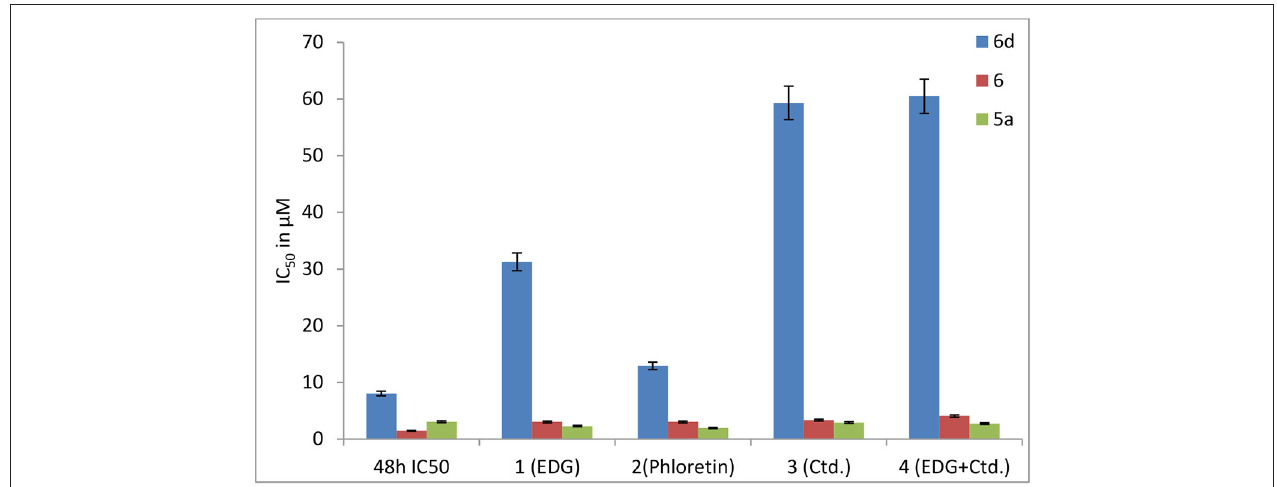
FIGURE 10 | Effects of EDG (1), phloretin (2), Ctd. (3), and the mixture of EDG and Ctd. (4) on the IC 50 values of 6, 6d and 5a in MDCK cells.